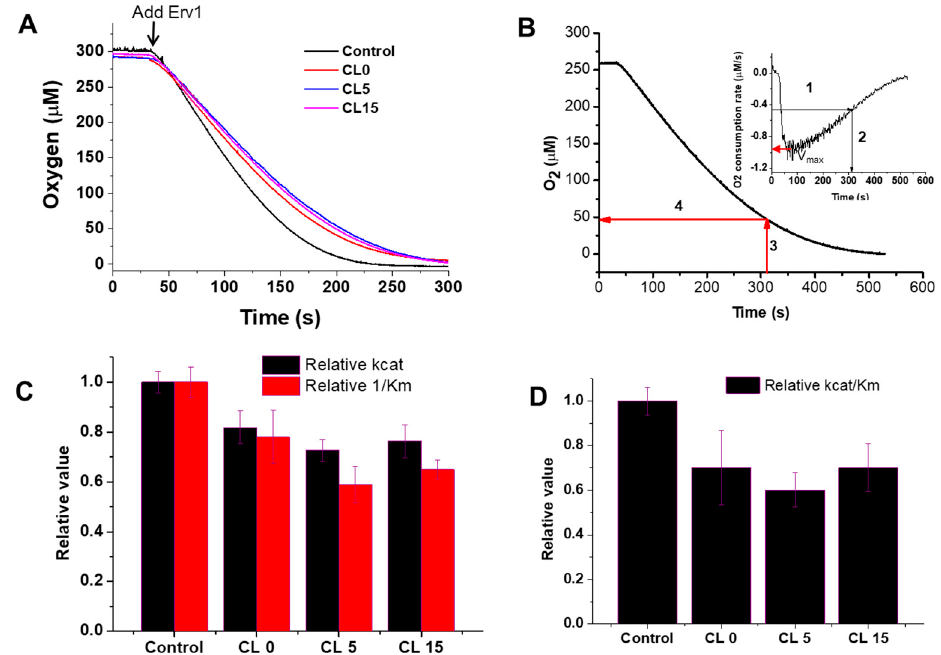
Figure 4. Effects of liposomes on the oxidase activity of Erv1. ( A ) Time course of oxygen consumption by 5 mM DTT catalyzed by 5 µM Erv1, in the absence (Control) and presence of 0.5 mM liposomes CL0, CL5, and CL15, respectively. The molar ratio of lipids:Erv1 was 100:1. ( B ) An example of how the oxygen consumption curve and the first derivative plot (insert) were used to identify the time point at which 50% of the maximal velocity (V max ) was reached; this was then used for K m estimation. ( C ) The relative oxidase k cat (black) and 1/K m (red) of Erv1. ( D ) Relative oxidase catalytic efficiency of Erv1. Control: without liposomes. CL0, CL5, and CL15: 0.5 mM liposomes. The error bars represent the standard error of the mean (SEM), n = 3; differences between each result and the corresponding controls were statistically analyzed using Kruskal–Wallis (one-way ANOVA) test, all p < 0.05.